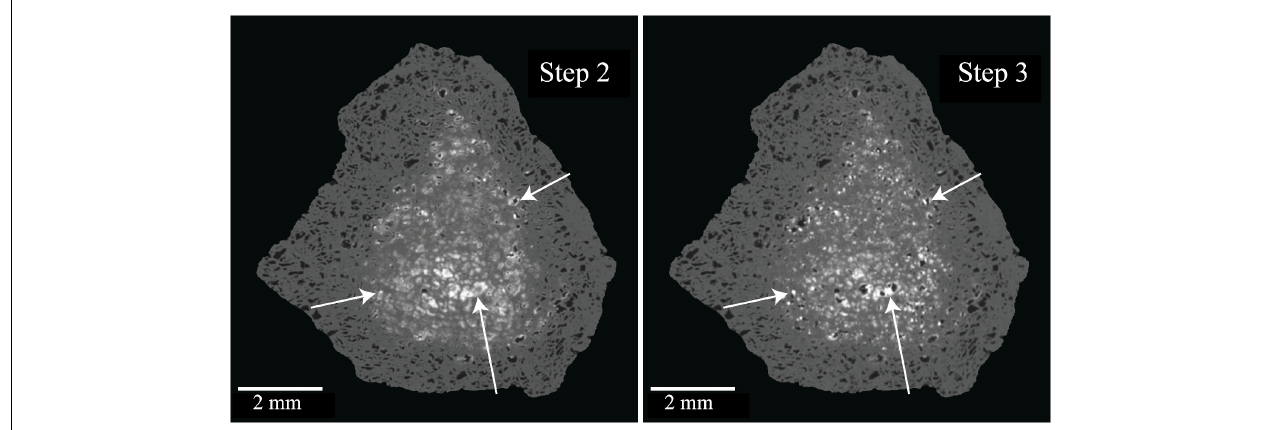
FIGURE 3 | XCT slices through same location in samples A before (left) and B after (right) HF digestion step highlighting the formation of highly attenuating phases.